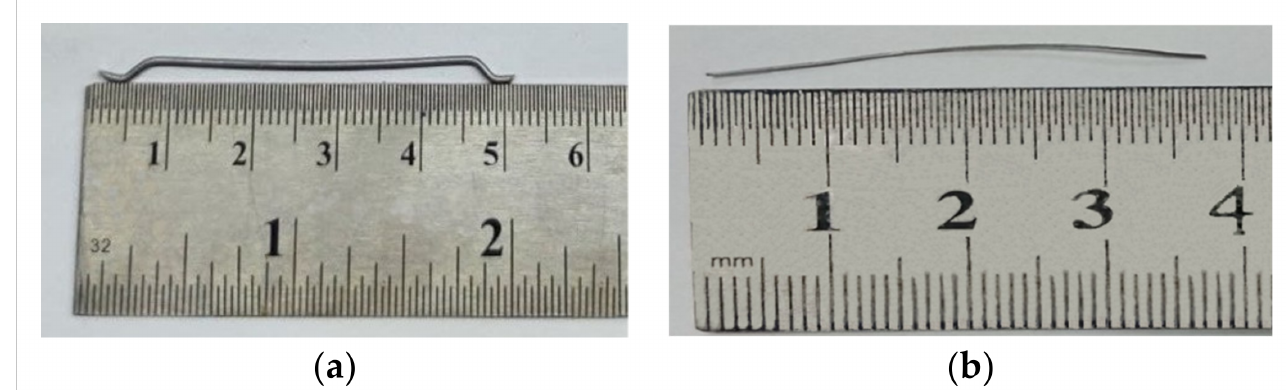
Figure 1. Steel anchor fiber ( a ), polypropylene fiber ( b